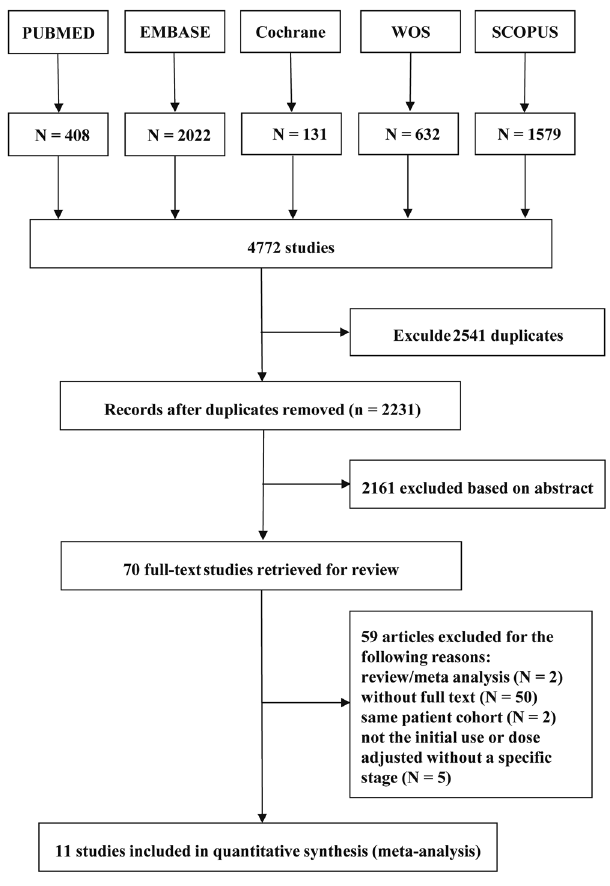
Figure 1. Flow chart for study search (PRISMA